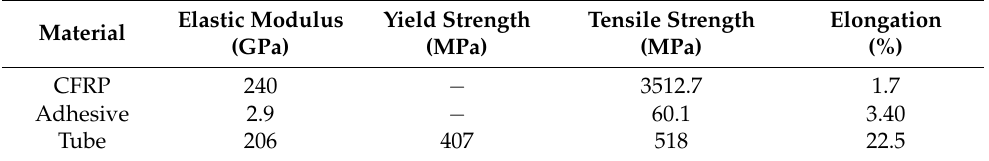
Figure 5. Size of specimens. ( a ) Front view; ( b ) Vertical view and welding details. Table 2. Mechanical properties of test